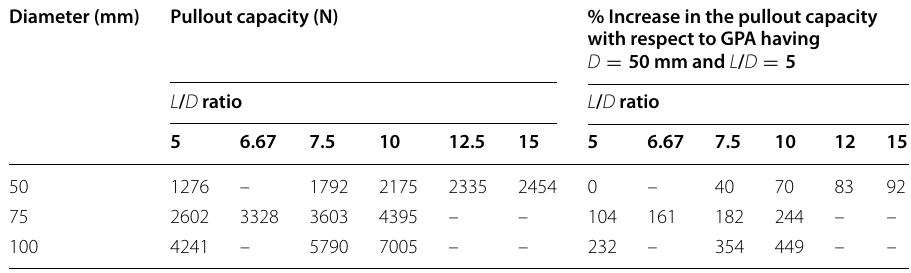
Table 11 Comparison of the pullout capacity of a single GPA for different cases Diameter